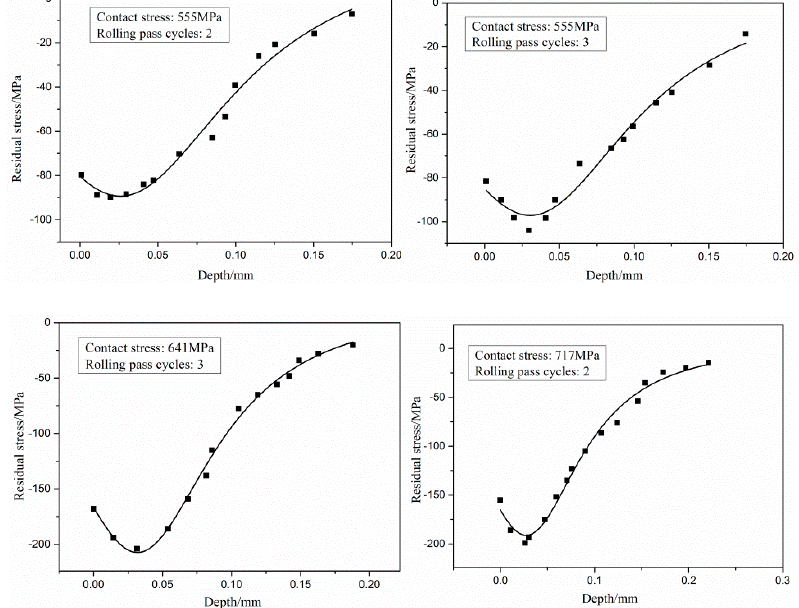
Figure 6. Residual stresses in depth direction.